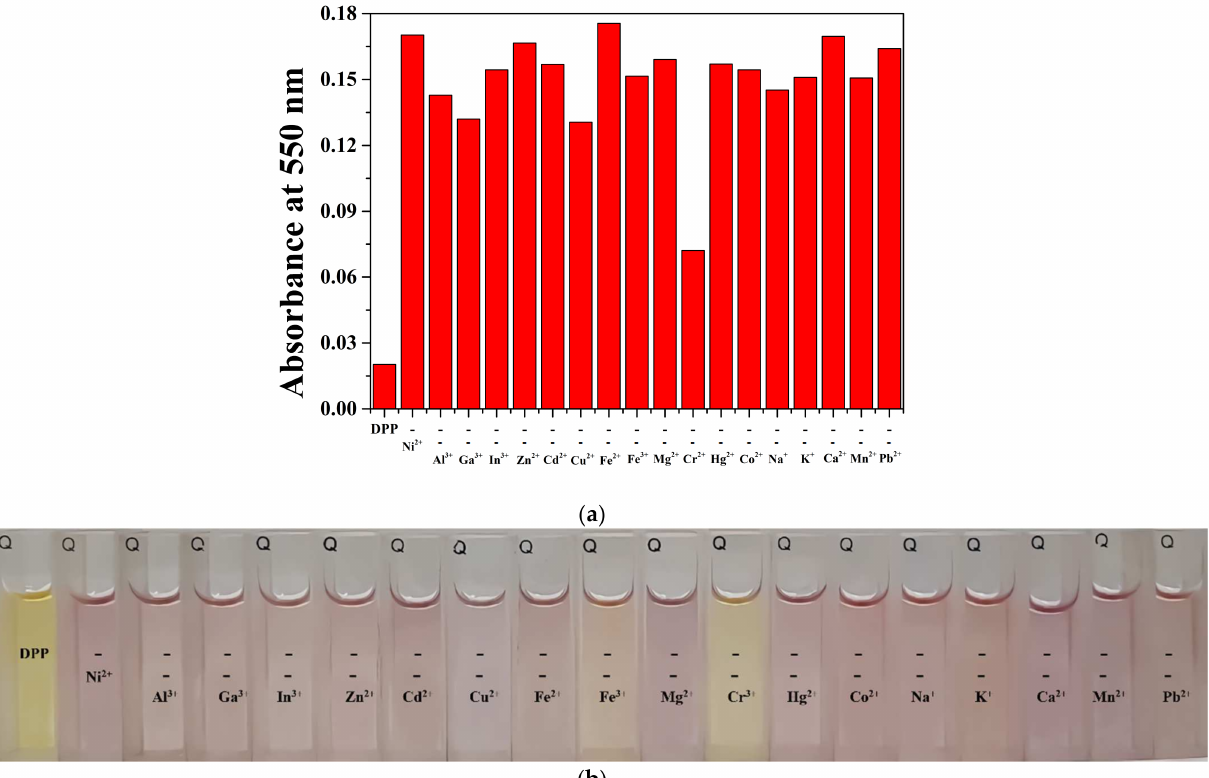
Figure 7. ( a ) Absorption variations of DPP (20 µ M) with Ni 2+ (20 eq.) and metal ions (20 eq.). ( b ) Color variations of DPP (20 µ M) with Ni 2+ (20 eq.) and metal ions (20 eq.).